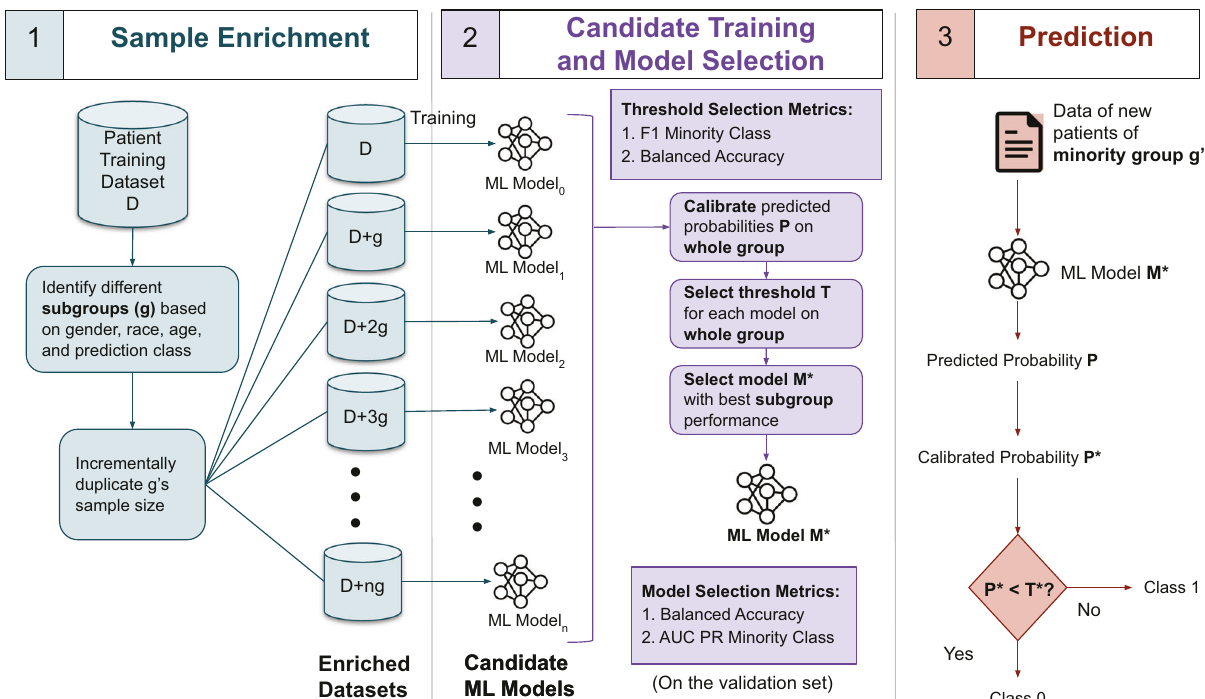
Fig. 1 Work fl ow for improving data balance in machine learning prognosis prediction using double prioritized (DP) bias correction. Sample Enrichment prepares a number of new training datasets by incrementally enriching a speci fi c demographic subgroup; Candidate Training is where each of the n + 1 datasets is used for training a candidate machine learning model; Model Selection identi fi es the optimal model; Prediction applies the selected model on new patient data. AUC-PR represents the area under the curve of the precision-recall